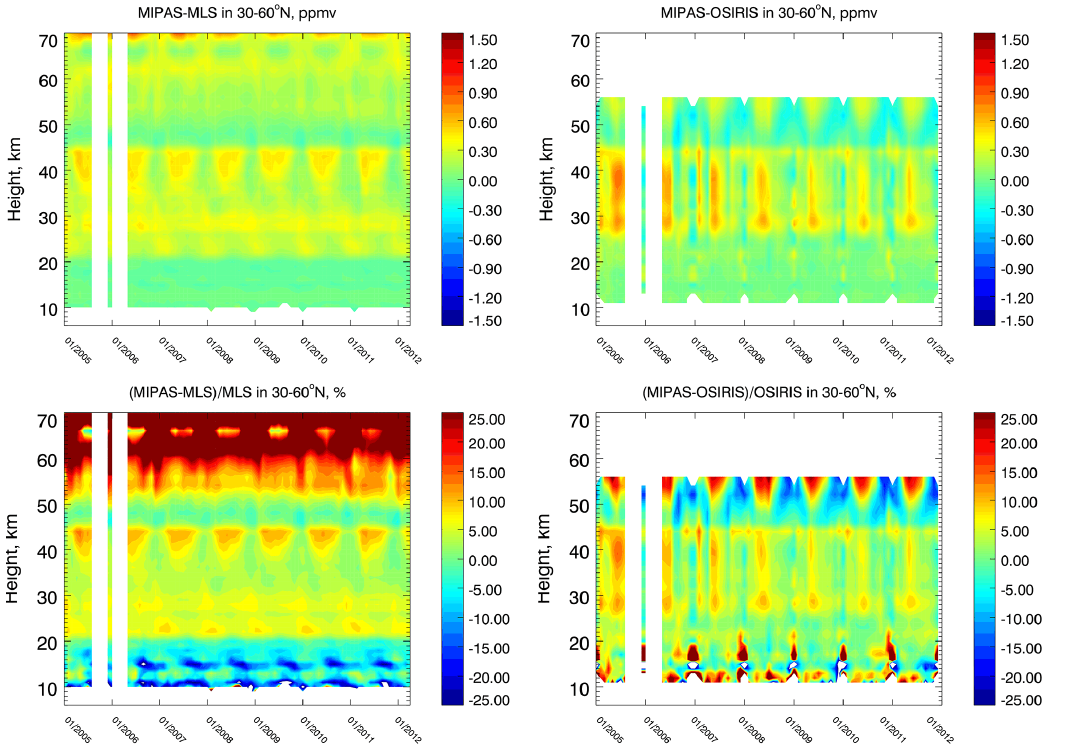
Figure 9. Evolution of absolute (upper panels) and relative (bottom panels) monthly mean differences between MIPAS and the reference instrument in 2005–2012 at 30–60 ◦ N for MLS (left) and OSIRIS